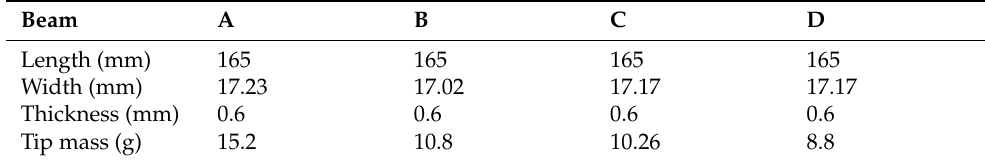
Table 2. The parameters of the cantilevers utilized for validation